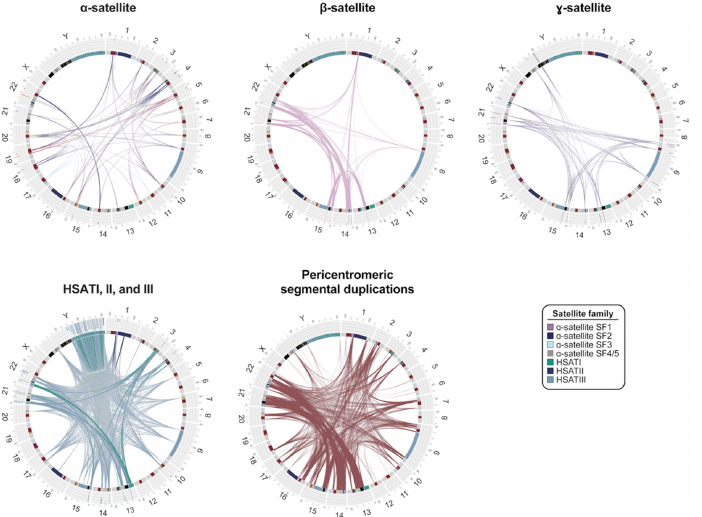
Figure 3. Interchromosomal relationships between centromeric satellite DNA and pericentromeric segmental duplications. Circos plots showing sequence relationships among four different satellite families as well as pericentromeric segmental duplications in the T2T-CHM13 genome. Connecting line widths for satellite families indicate the proportion of 75-mers shared between arrays (i.e., thicker lines indicate greater overall sequence similarity between different arrays of the same family). α-satellite lines are colored by their suprachromosomal family (SF) assignment. Radial bar plots indicate specificity of 75-mers proportionally, with white indicating 75-mers unique to the array, light gray indicating 75-mers shared with other centromeric regions, and black indicating 75-mers shared with regions outside of centromeres. The pericentromeric segmental duplication circos plot shows pairwise alignments between pericentromeric regions that are >1 kbp and >90% identical.